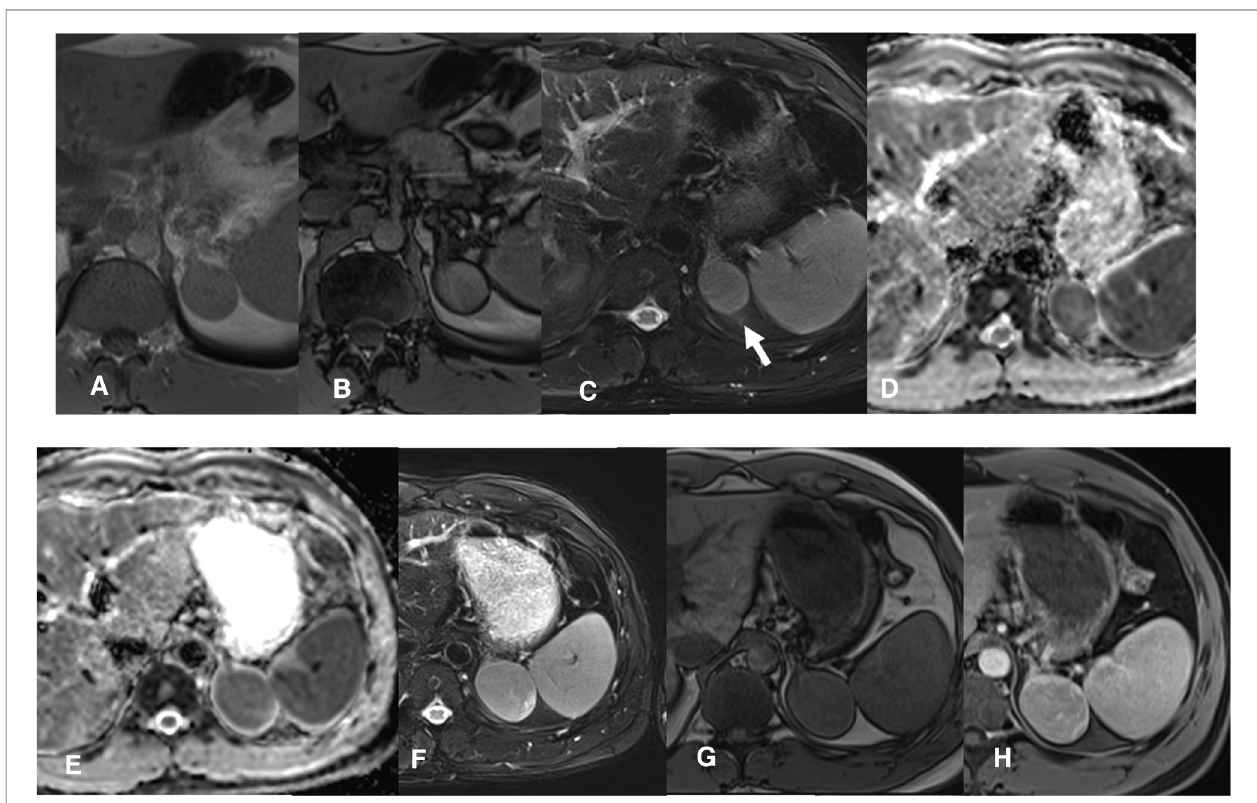
FIGURE 2 | MRI scan 2019- Follow-up con fi rms the presence of a slightly enlarged, compared to the CT control, left adrenal solid mass. The T1 in-phase (IP) and out-of-phase (OOP) sequences ( A,B ) con fi rm a substantial absence of lipid content. The mass is rather homogeneous, isointense in T2 STIR ( C , arrow), solid with restriction in the diffusion map ( D ). MRI scan 2020- A clear enlargement of the adrenal mass is present (maximum diameter about 5 cm), which is heterogeneously solid in the DWI map ( E ). Also in T2 w ( F ) the mass is larger and heterogeneous, in T1 w the mass has a parenchymal signal ( G ) with a slightly inhomogeneous post- contrast impregnation ( H , venous